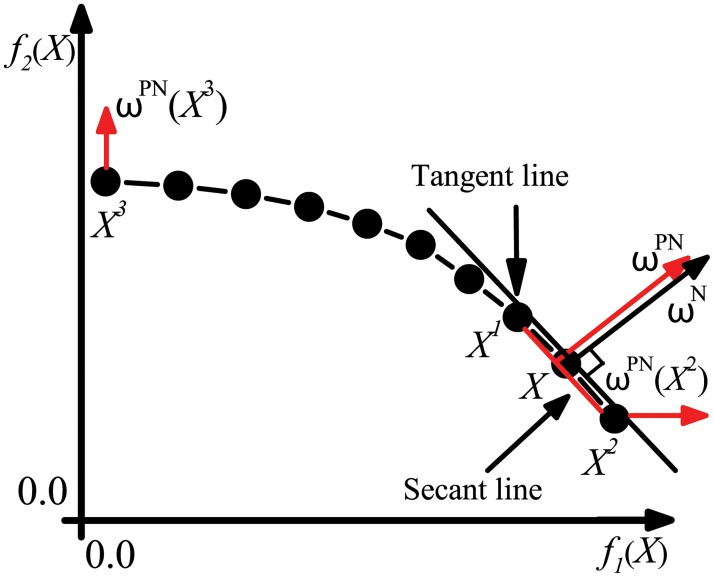
Illustration of pseudonormal vector.
ω
N is the vector of normal line, ω
PN is the pseudonormal vector.